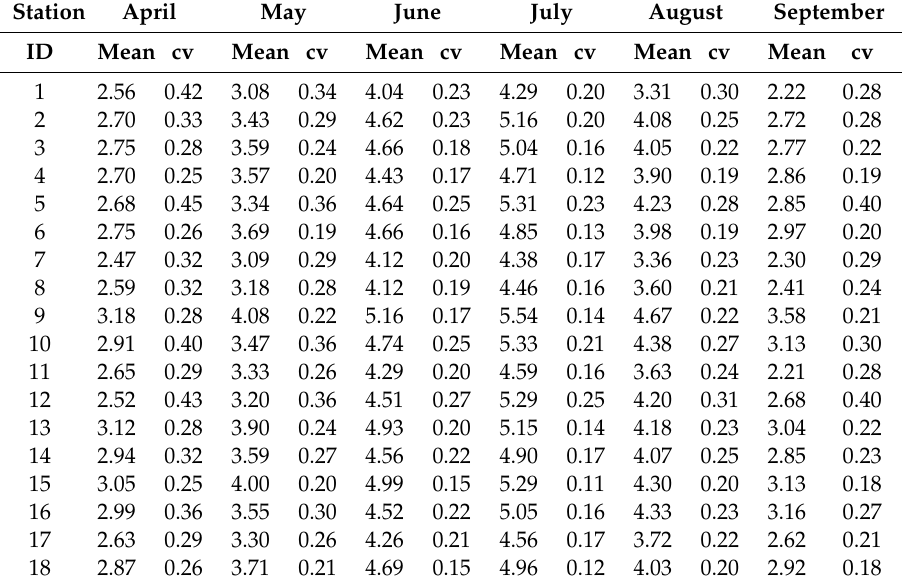
Table 3. Monthly statistics for Food and Agriculture Organization of the United Nations